Question: Summarize what this figure shows in one sentence.
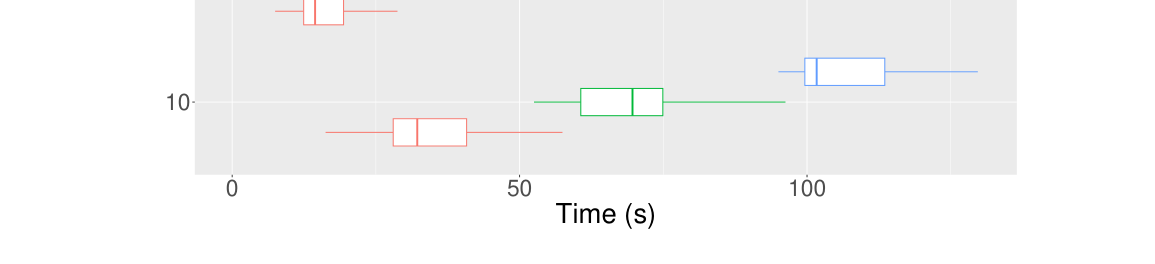
Answer: Simulation for number of initialisations: boxplots of computational time (s) for different values of n and ninit.